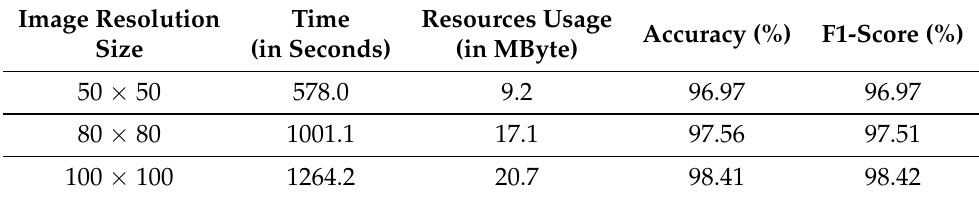
Table 2. Comparative analysis of detection performance on